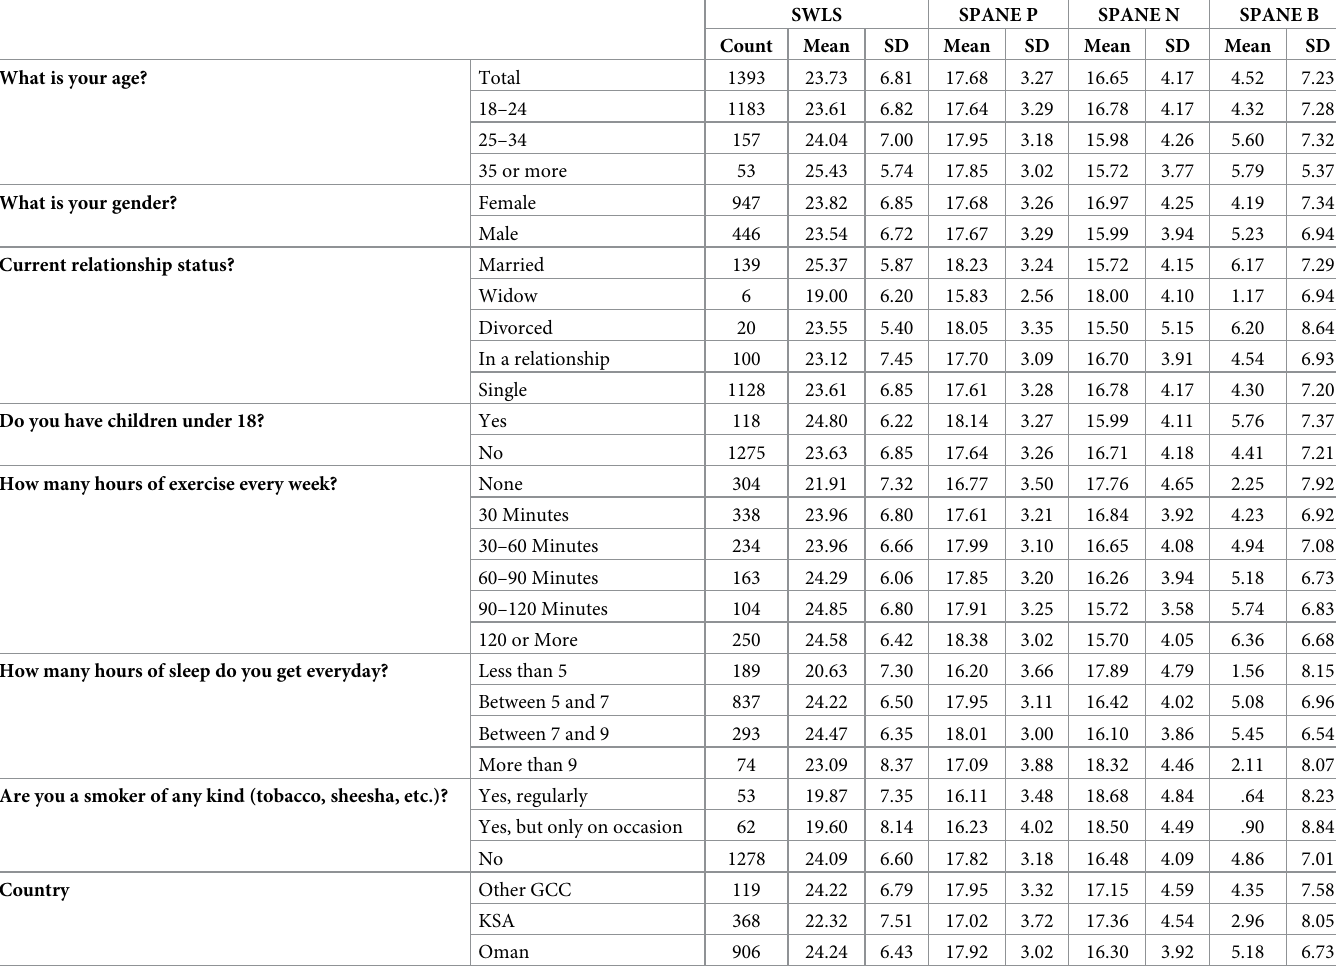
Table 1. Descriptive statistics of the sample (N =